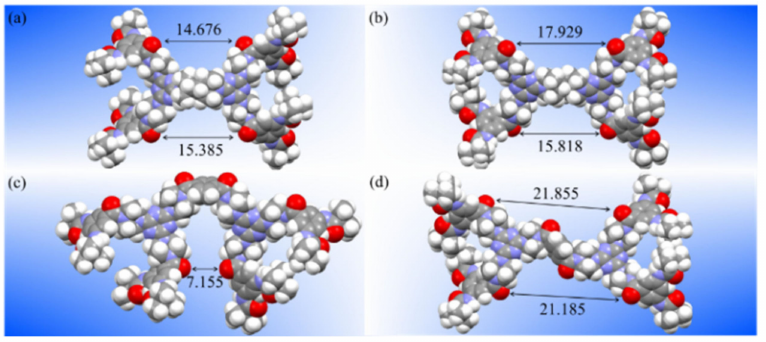
Figure 6. The molecular conformations of dendrimers 2 and 3 in a space-filled model, O: red, C: gray, N: purple, H: white; ( a ) the H,H (cid:48) -cis of 2 ; ( b ) the H,H (cid:48) -trans of 2 ; ( c ) the O,O (cid:48) -cis of 3 ; ( d ) the O,O (cid:48) -trans of 3